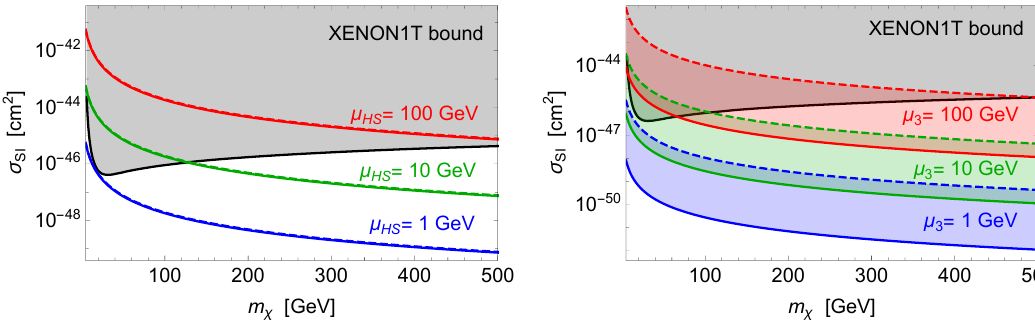
Figure 1 . The spin-independent DM-nucleus interaction cross section for di(cid:11)erent parameter values regardless of the relic density of the DM candidate, (cid:31) . The cross-section values constrained by the XENON1T experiment [1, 2] are shown in gray. In each plot, the solid lines represent the cross section for the minimum considered value for sin (cid:18) = 0 : 01 and the dashed lines represent the maximum considered value of sin (cid:18) = 0 : 2. In all plots, w = 250 GeV, m 2 = 200 GeV and the U(1)-breaking parameters which are not shown are set to zero, except for (cid:22) 0 2